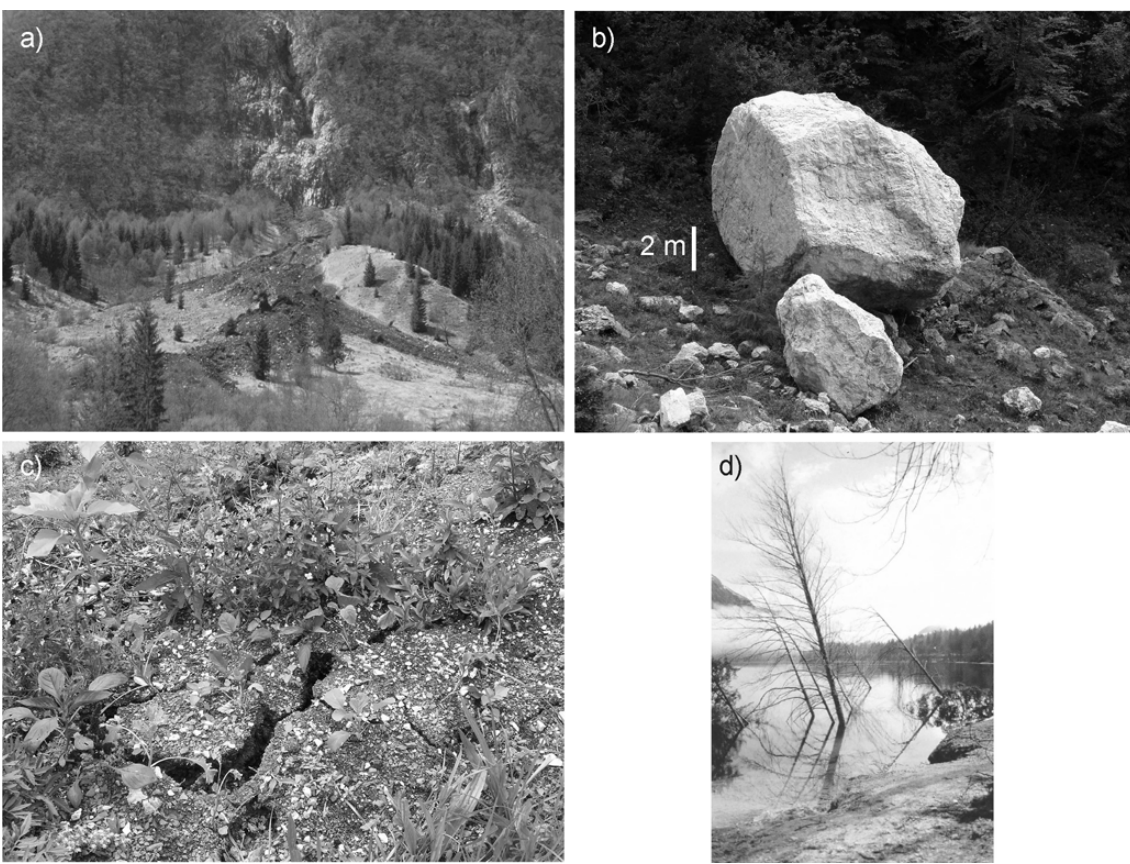
Fig. 6. Selection of other environmental effects. (a) Mudflow in Lepena valley; (b) huge boulder in Doliˇc; (c) cracks in ground in Magozd; (d) Bohinj lake shore